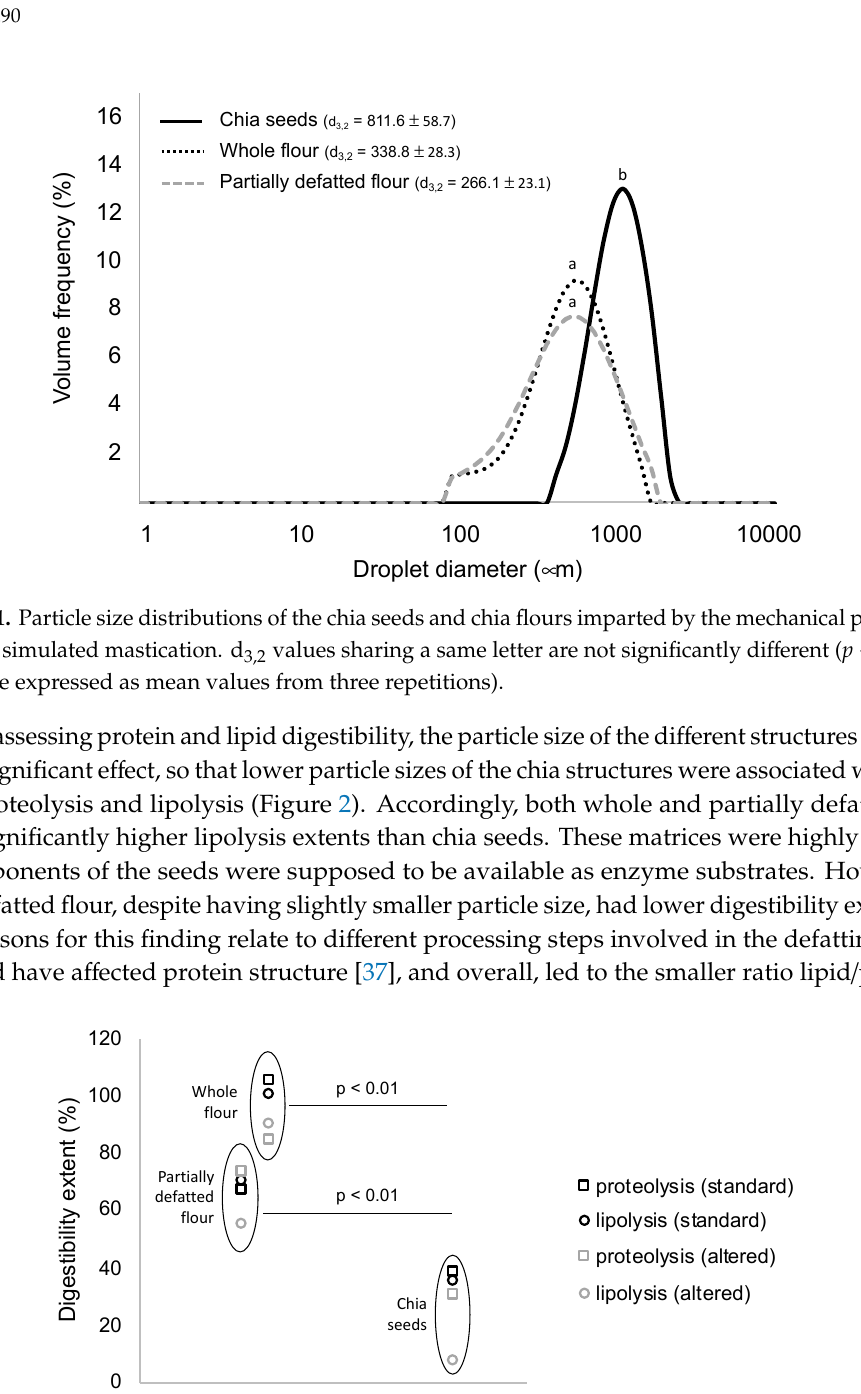
Figure 2. Milling process of chia seeds reduces particle size, which significantly increases lipid and protein digestibility in chia flours as compared to chia seeds (after simulation of mastication) (data are expressed as mean values from three repetitions).